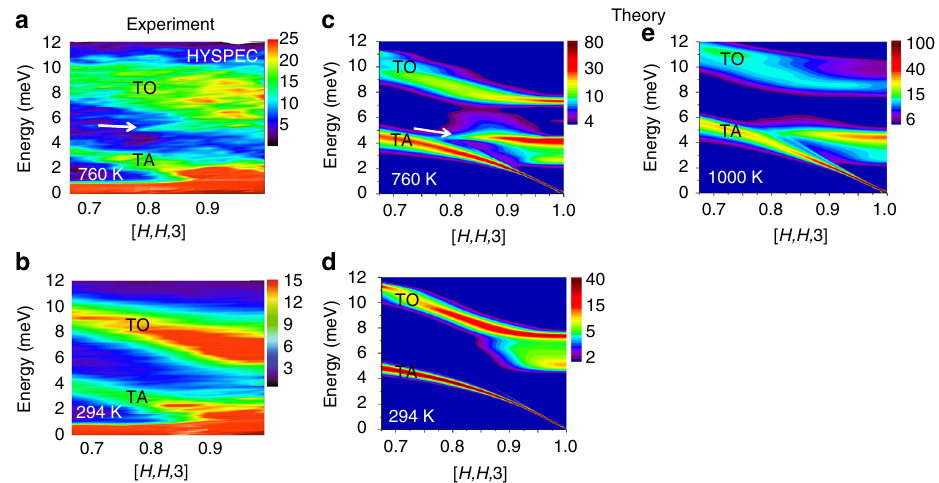
Fig. 2 Time-of- fl ight cold neutron scattering measurements and ab initio simulations. These measurements resolve fi ne energy structure in the spectral distribution for comparison with the ab initio simulations. a , b Measurements of the TO and TA phonon spectral intensities along Q = [ H , H , 3] at 294 and 760 K (out-of-plane direction integrated ±0.1 r.l.u.). c , d Ab initio molecular dynamics simulation predictions of the same phonon spectral intensities. Intensity bars are in arbitrary units. e Simulation at 1000